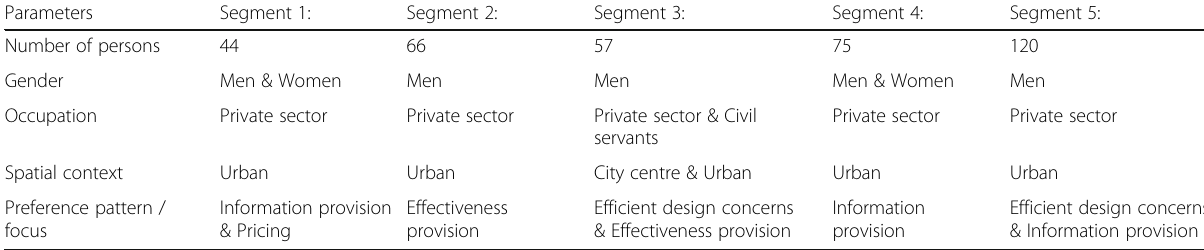
Table 4 Final Segment profiles